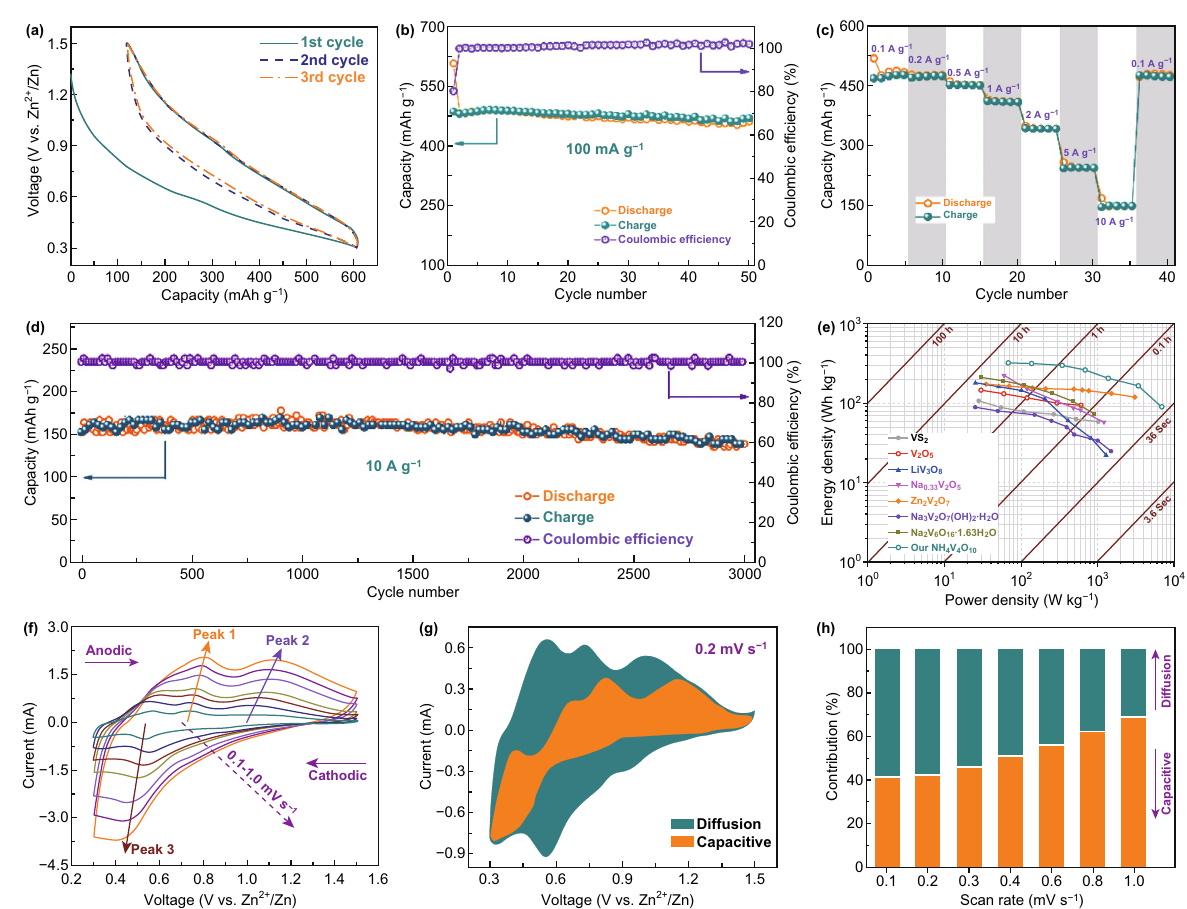
Fig. 3 Electrochemical characterization of the 3D‑NVO cathode. a Galvanostatic discharge and charge profiles for the first three cycles at 100 mA g −1 . b Cycling performance at 100 mA g −1 . c Rate capability. d Long‑term cycling performance at a high rate of 10 A g −1 . e Ragone plots of our 3D‑NVO cathode, compared with some advanced vanadium‑based cathodes for ZIBs. f CV curves at scan rates from 0.1 to 1.0 mV s −1 . g Evaluation of capacitive contribution to the total charge storage (e.g., 0.2 mV s −1 ). h Contribution ratio of the capacitive‑con‑ trolled and diffusion‑controlled capacities at various scan